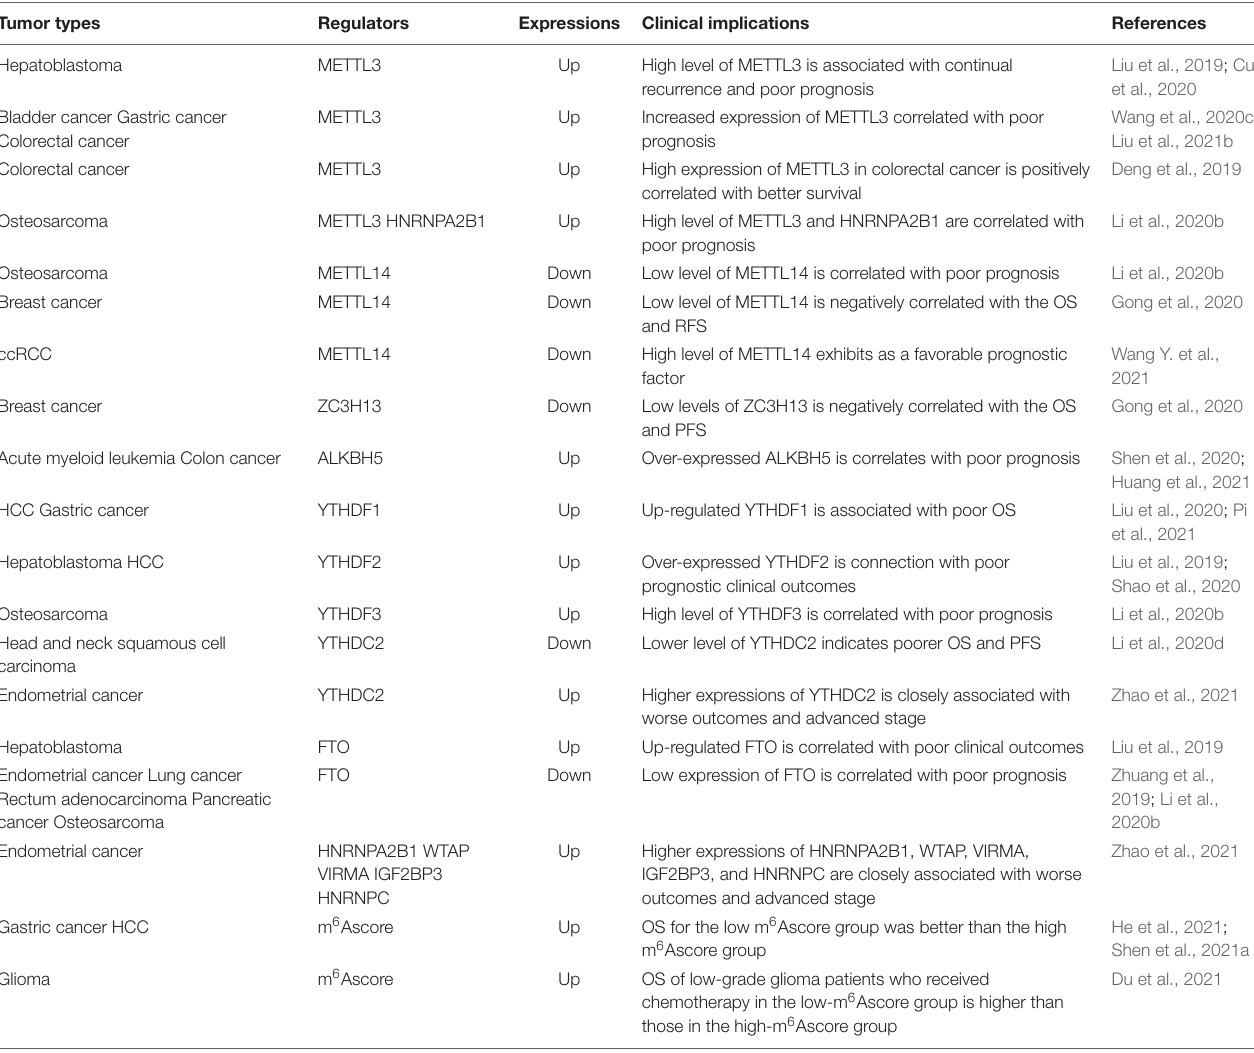
TABLE 2 | The potential clinical implications of RNA m 6 A modification in